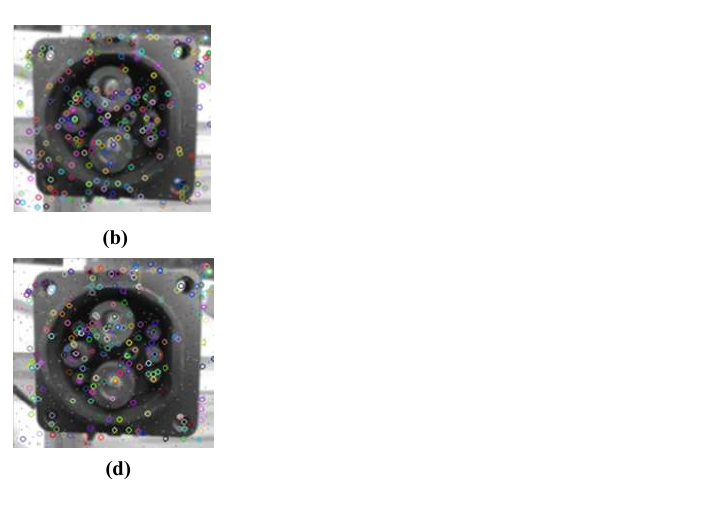
Figure 6. Feature points of filtering processed image: ( a ) before filtering; ( b ) by mean filtering; ( c ) by median filtering; ( d ) by Gaussian filtering. Table 1. Performance comparison of filtering methods.